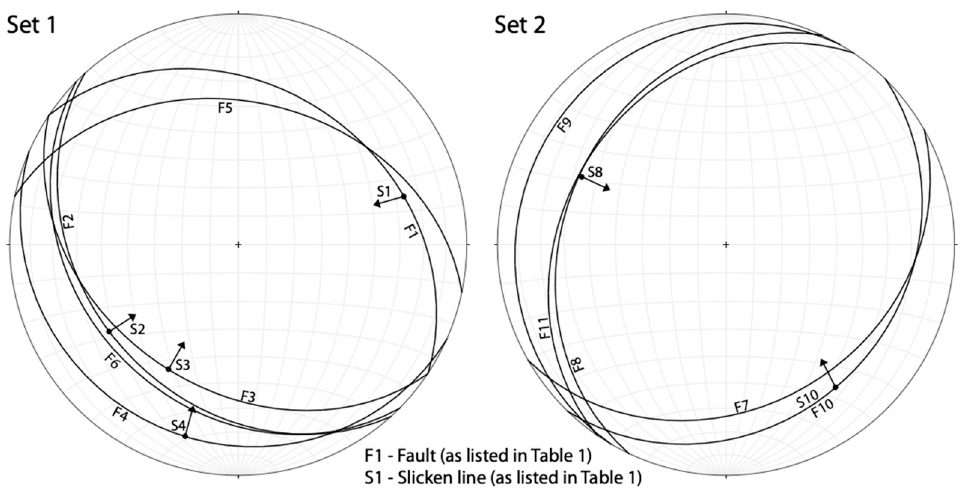
Figure 5. Stereonets for set-1 and set-2-thrusts (total eleven faults). These are lower hemisphere plots. Faults are depicted as circles, slickenlines are depicted as dots. Arrows indicate direction of thrust movement.